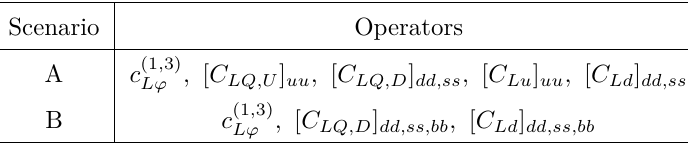
Table 17 . Multi-operator scenarios A and